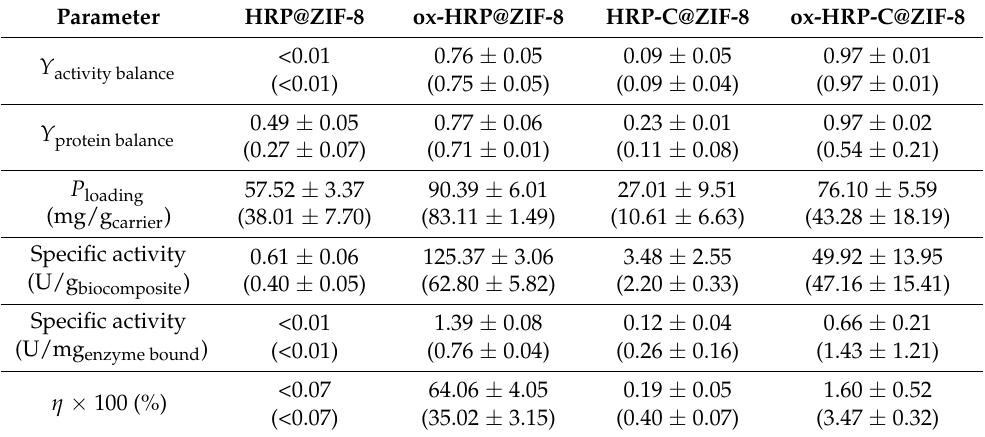
Table 3. Key immobilization performance parameters for four types of biocomposites, washed with water alone or washed with water and a 1 M NaCl solution (data in parentheses) *.